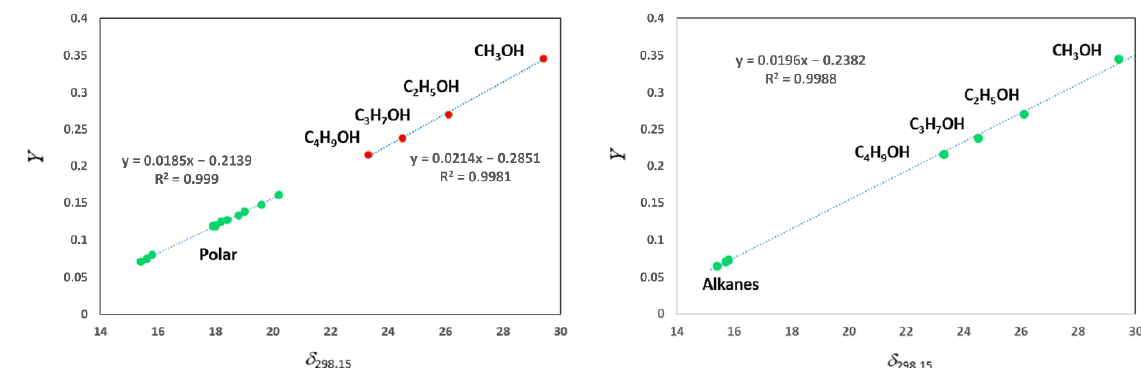
Figure 2. Regression of solubility parameters δ 298.15 of different solutes and Y -module ( Y = ( δ 1 ) 2 /( RT ) − χ 12 / V ∗ is the left part of Equation (5)) for [C 6 mim][SCN] derived from experimental γ ∞ values [39]. ( Left ): separate treatment of collection of polar molecules (see text) and aliphatic alcohols. ( Right ): joint treatment of linear alkanes and linear alcohols.